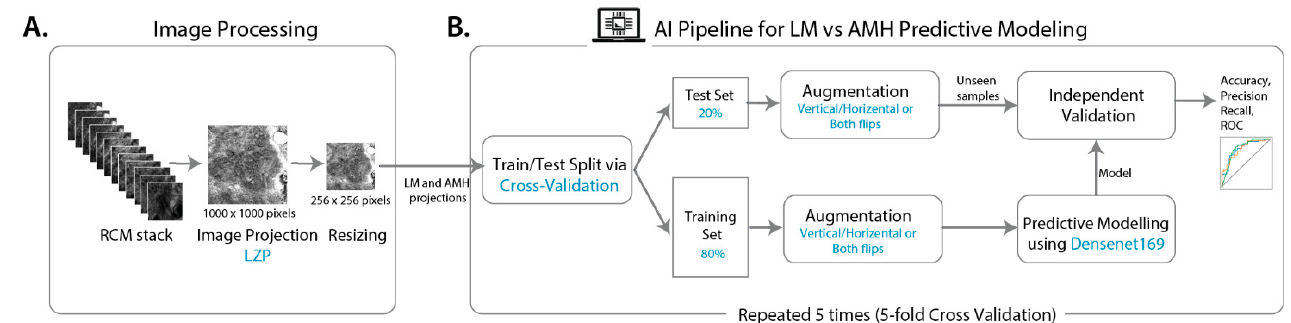
Figure 1. The schematic workflow of the study comprising image processing including projection and resizing ( A ), and deep learning model development and validation ( B ).